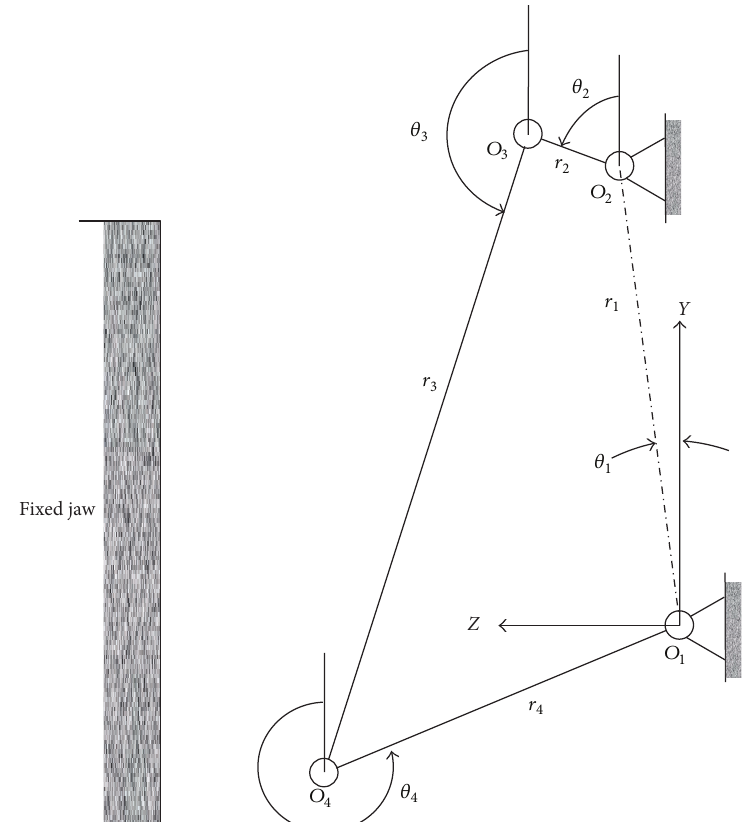
Figure 1: Kinematical model of the single toggle jaw